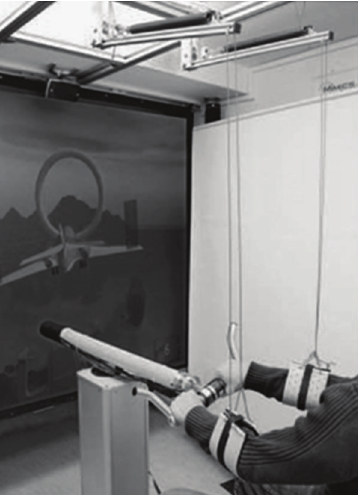
Figure 17: Adaptive Bimanual Robotic Training. Reprinted with